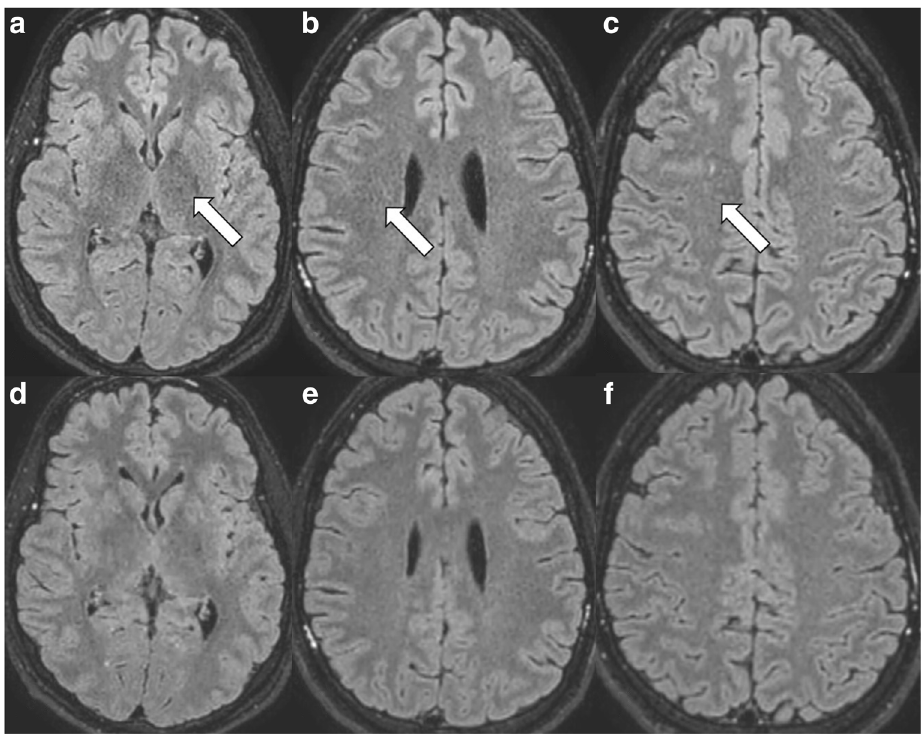
Fig. 6 The starry-sky artefact. This artefact was visible as grainy image noise ( white arrows ) on the transverse reconstructions of the 3D FLAIR sequence with Compressed SENSE ( a - c ) if compared to corresponding transverse reconstructed images of a 3D FLAIR with Compressed SENSE but without this artefact in the same volunteer ( d - f ) after sequence repetition. The artefact was also visible on coronal reconstructions and on sagittal source images (not depicted) of the 3D FLAIR sequence